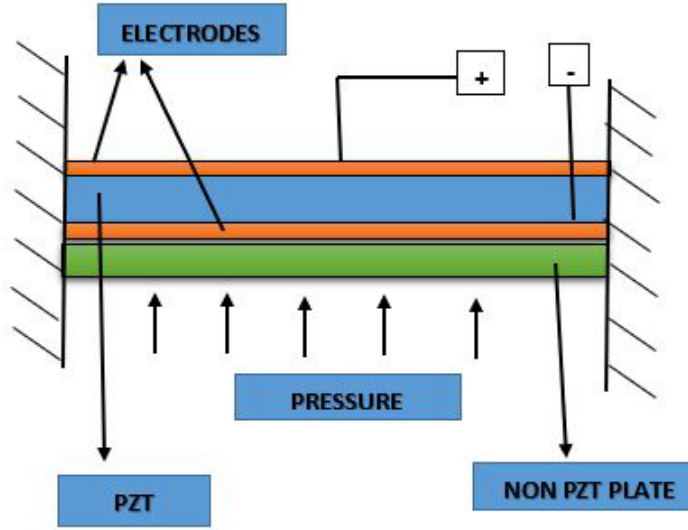
Figure 20. Plate-type mechanism-based PEH